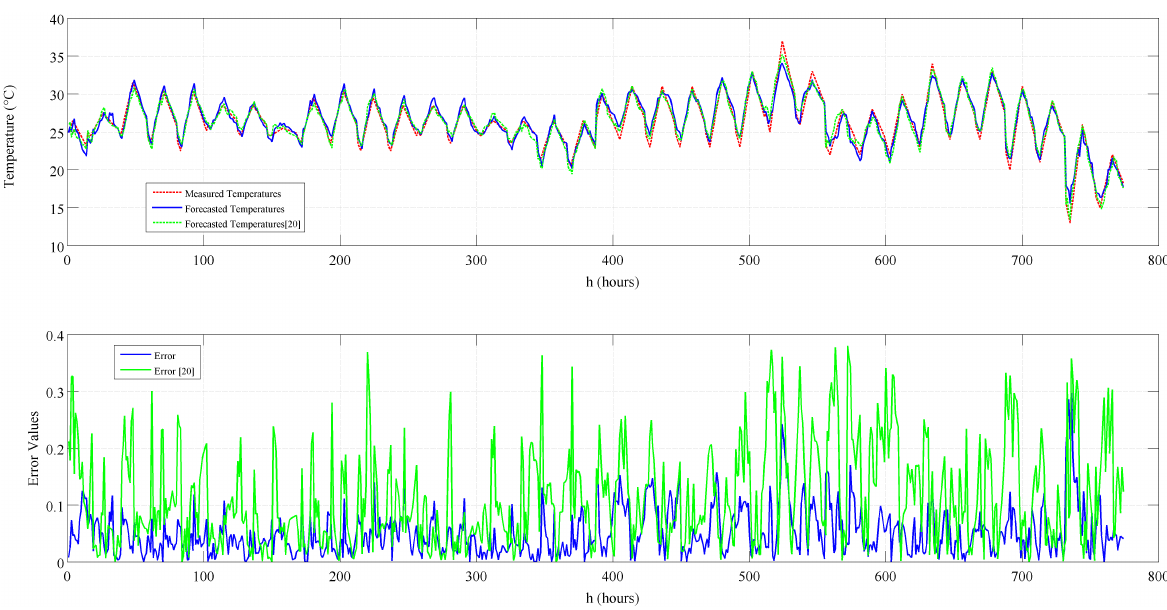
Figure 3. Measures of forecasting indoor temperatures ( top ) and forecasting error ( down ) (summer scenario with 50 neurons in the hidden layer).